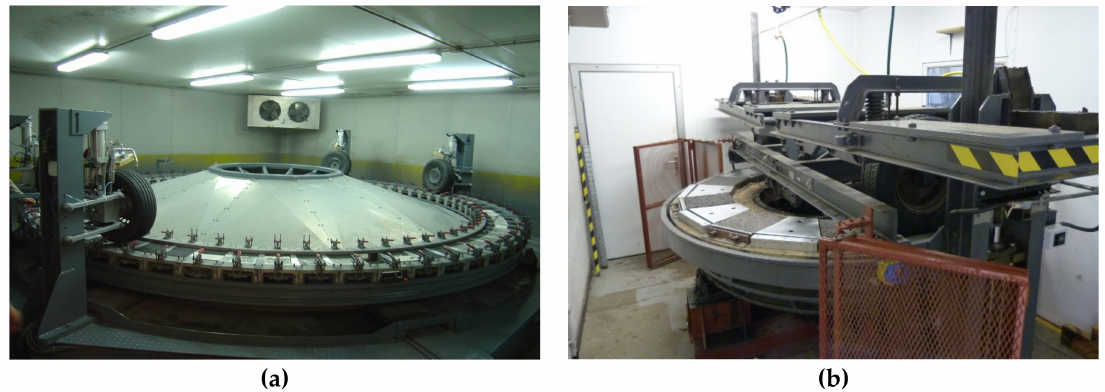
Figure 2. ( a ) The wear simulator turntable located at Aetec Laboratories, Madrid; ( b ) the road test machine located at Ulster